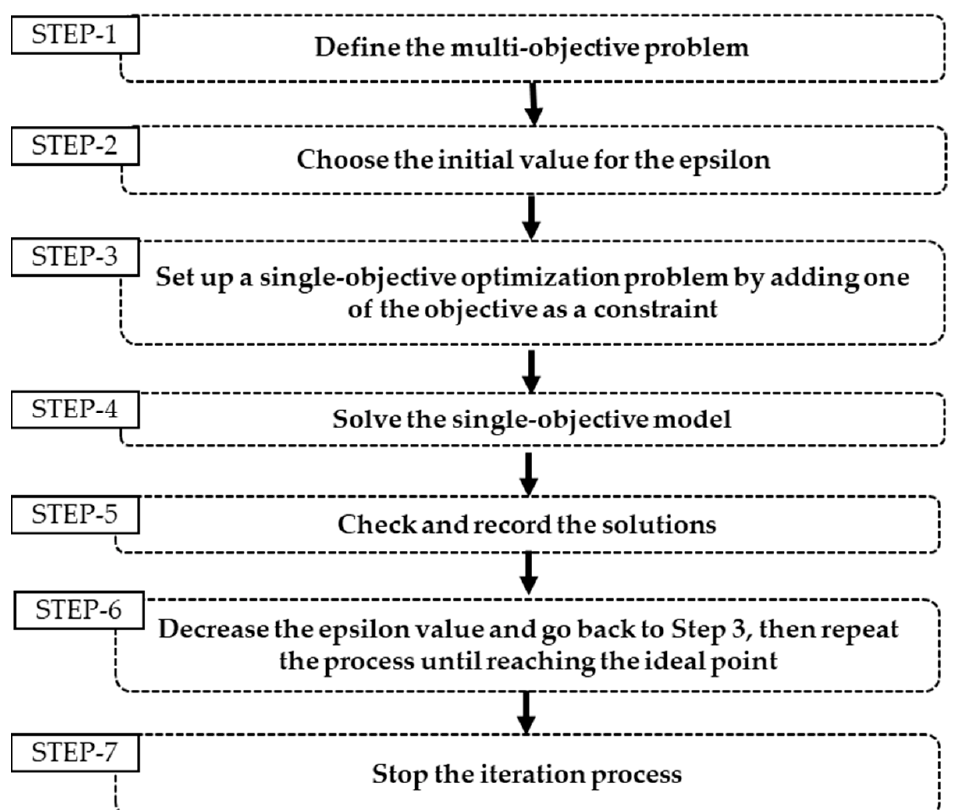
Figure 17. Flowchart for solving the optimization model using the epsilon constraint method.